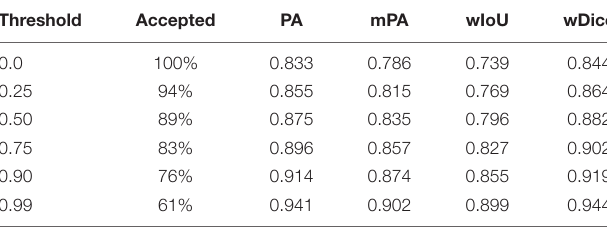
TABLE 2 | Classification scores for the CNN patch-based image classifier compared against